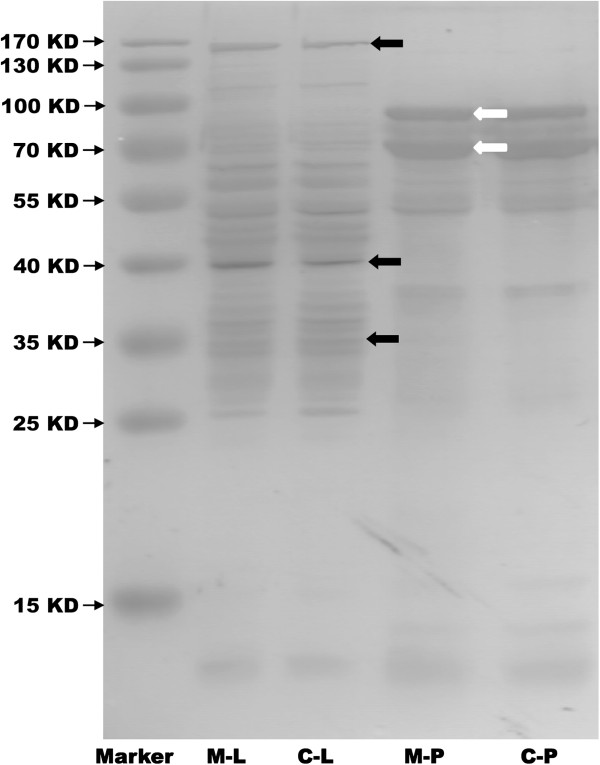
The perfusates presented a different protein composition compared to liver cytosol extracts. Eight micrograms of protein from the perfusate and cytosol mixturesa from both the model and control rats was loaded onto the gel, and the gel was subsequently silver-stained. Substantial differences were detected in the perfusate and cytosol. Many high-abundance cytosolic proteins (black arrows) were not observed in the perfusates, whereas some proteins were enriched in perfusates (white arrows). M-L: Liver cytosol mixture from the model rats. C-L: Liver cytosol mixture from the control rats. M-P: Perfusate mixture from the model rats. C-P: Perfusate mixture from the control rats. a. The cytosol mixture was prepared according to our previous work [3]. Briefly, the perfused rat livers were snap-frozen with liquid nitrogen, and then ground into a powder with a pestle. The liver tissue powder was suspended in 40 mM Tris buffer on ice, followed by centrifugation at 12000 g for 30 minutes at 4°C. The supernatants were collected as liver cytosol extracts. The cytosol mixture was prepared by pooling liver cytosolic extracts from five model or control rats.